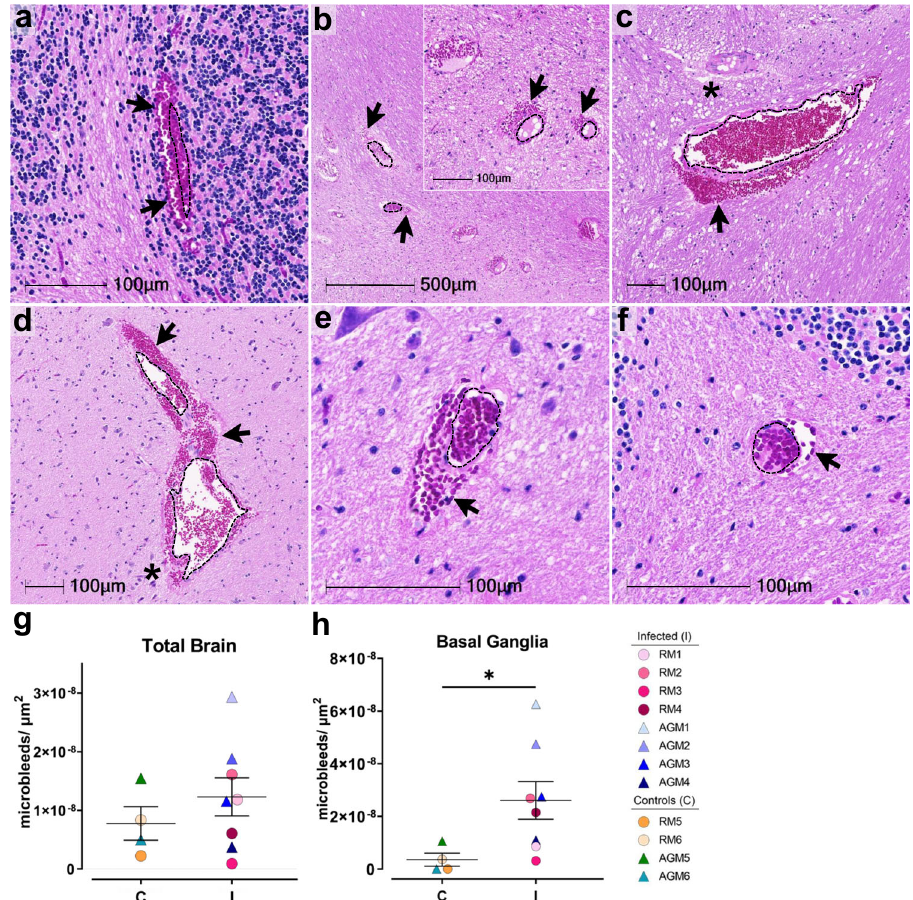
Fig. 3 Multiple microhemorrhages in CNS of SARS-CoV-2 infected NHPs. H&E examination of infected animals revealed microhemorrhages, as demonstrated in cerebellum (AGM1 a ), brainstem (AGM2 b , AGM4 c ), and basal ganglia (RM4 d ), which tended to be larger and packed with red blood cells, as compared to non-infected controls, (RM6 brainstem e , AGM5 cerebellum f ). Erythrocyte extravasation into the brain parenchyma is indicated by black arrows. Asterisks denote tissue injury around damaged blood vessels. A dotted line outlines the vessel lumen in each panel. H&E was performed and assessed twice on all brain regions. The number of microbleeds/mm 2 was assessed in all brain regions ( g ) and found to be signi fi cantly greater in the basal ganglia ( h , * p = 0.0263), where n = 4 biologically independent samples in the control group and n = 8 biologically independent samples in the infected group. Statistics were performed with a two-tailed Mann – Whitney U test. * p ≤ 0.05. Data are expressed as mean ± SEM. Source data are provided as a scale bar = 500 µ